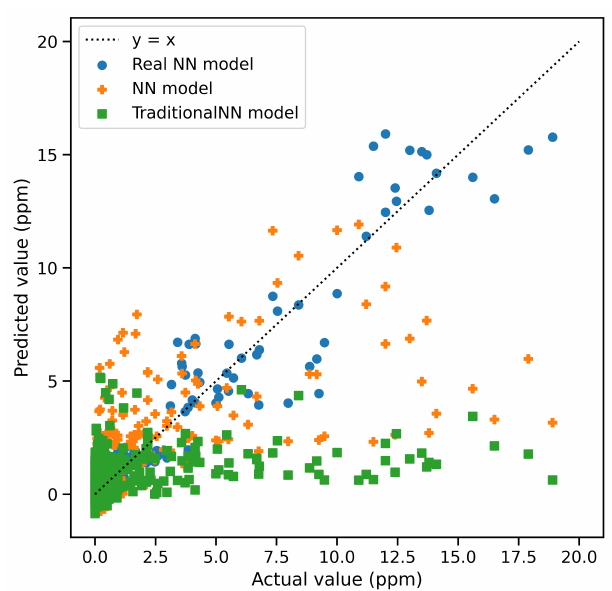
Figure 7. Simulation 23 actual versus predicted values on the testing data for each model.